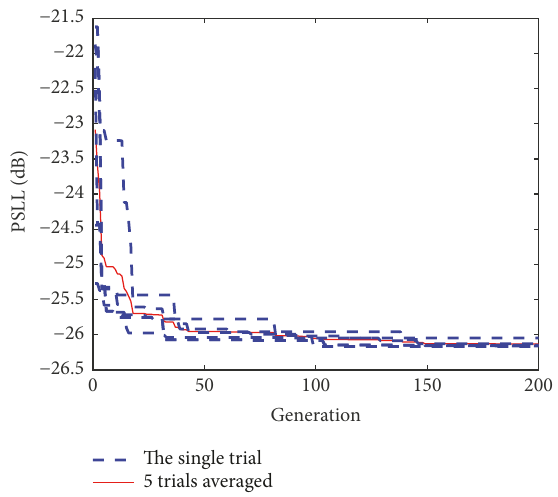
The single trial 5 trials averaged Figure 7: The convergence characteristics.